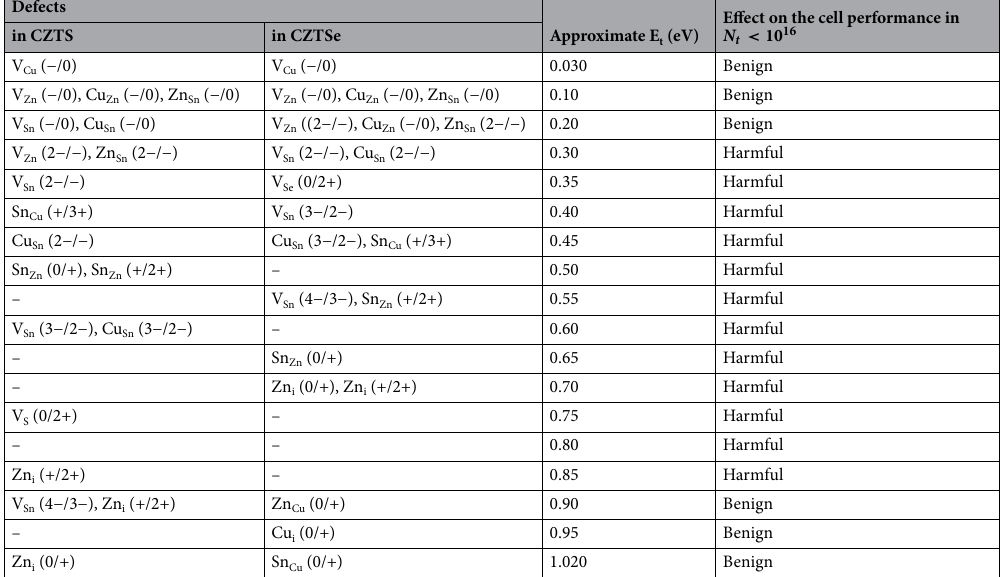
Table 4. Harmful and benign defects based on their influence on the cell performance.